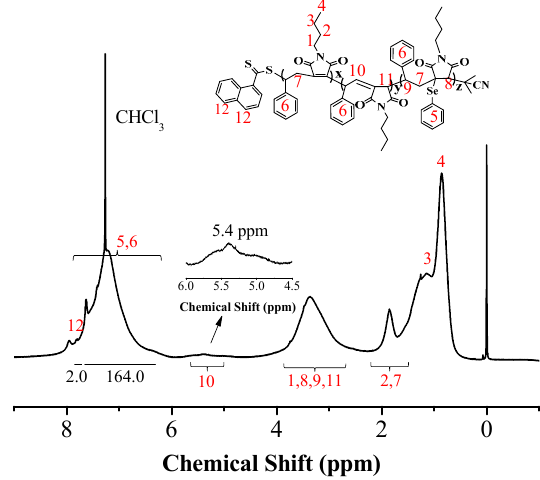
Figure 5. 1 H NMR spectrum of oxidized copolymer in CDCl 3 .